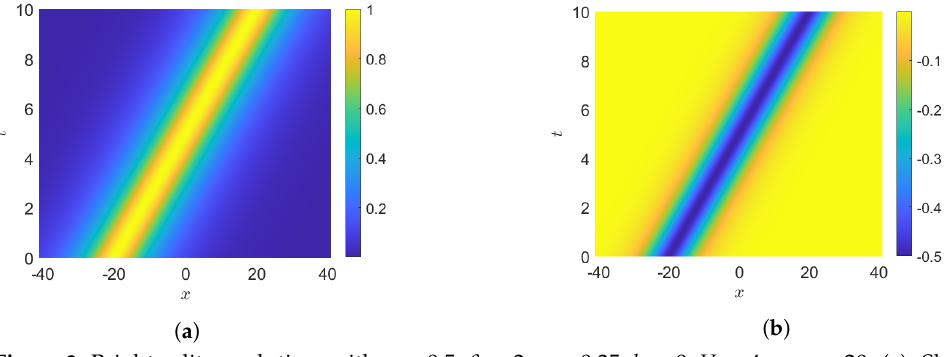
Figure 3. Bright soliton solution, with α = 0.5, β = 2, a = 0.25, b = 0, V = 4, z 0 = − 20. ( a ). Short wave | S | . ( b ). Long wave L